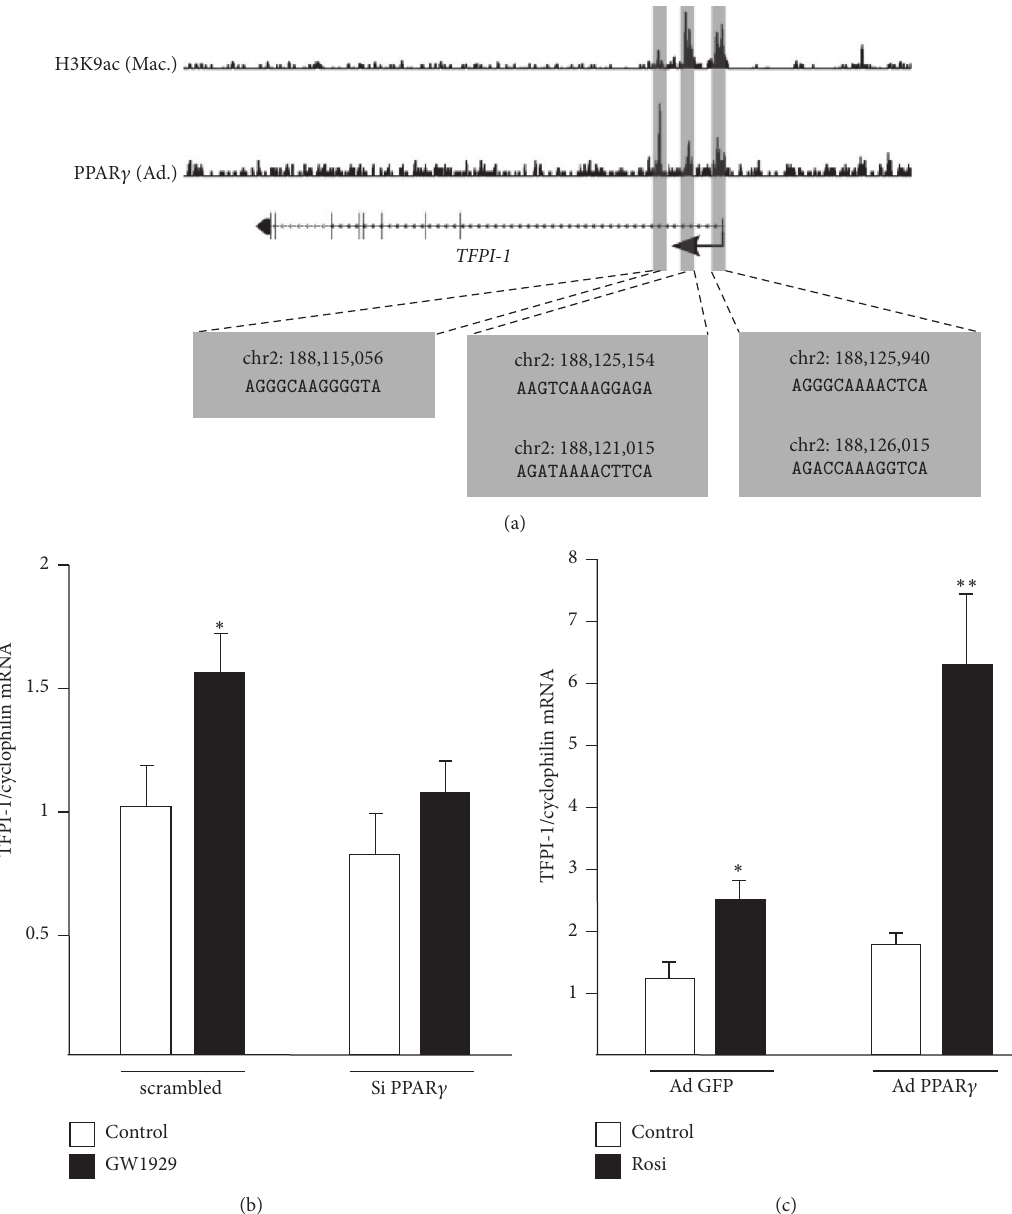
Figure 4: PPAR 𝛾 activation induces the expression of TFPI-1 in a PPAR 𝛾 -dependent manner. (a) H3K9ac ChIP-seq signals from M2 macrophages (Mac.) as well as PPAR 𝛾 ChIP-seqsignal fromhuman primary adipocytes (Ad.) are shown forthe TFPI-1 gene. Active regulatory regionsarehighlightedingrayandchromosomallocalization(Hg18)andsequencesofPPREidentifiedwithintheseregionsareprovidedatthe bottom. (b) Differentiated macrophages were transfected with scrambled or human PPAR 𝛾 siRNA and subsequently treated with GW1929 (600 nM) or DMSO (Control) during 24 h or were infected with a GFP (Ad-GFP) or a PPAR 𝛾 (Ad-PPAR 𝛾 ) adenovirus and then treated with rosiglitazone (24 h, 100 nM) (c). Statistically significant differences between treatment and control groups are indicated ( ∗ 𝑝 < 0.05 ; ∗∗ 𝑝 < 0.01 ).